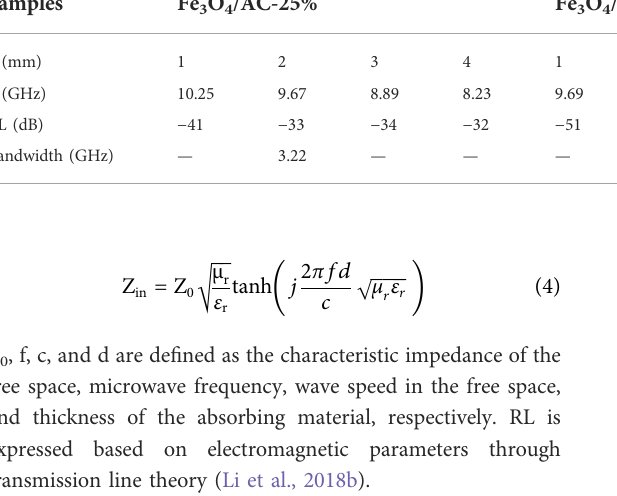
TABLE 3 The results of re fl ection loss in different thickness.